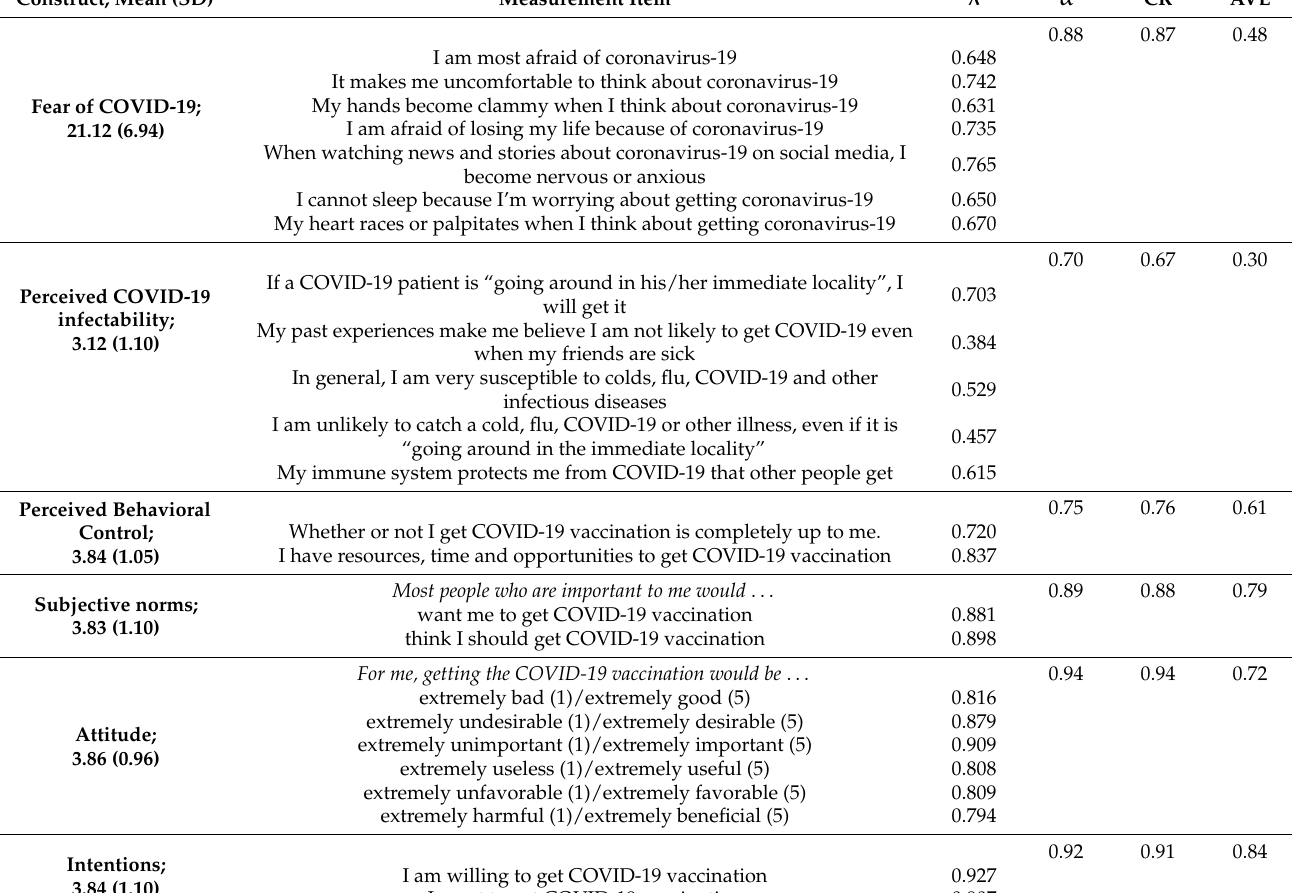
Table 3. Items for Study Measures with Descriptive Statistics, Reliability Coefficients, Factor Loadings, and Average Variance Extracted